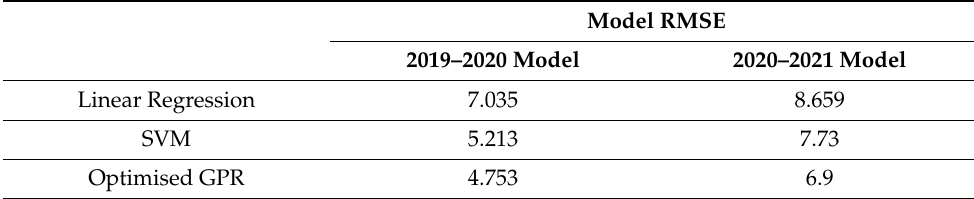
Table 3. Specific index for the concentration of